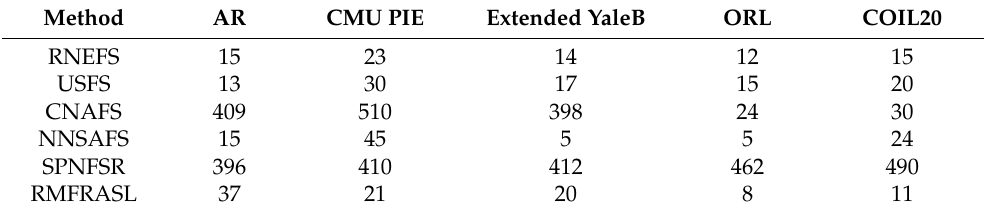
Figure 8. The convergence of the RMFRASL algorithm: ( a ) AR; ( b ) CMU PIE; ( c ) Extended YaleB; ( d ) ORL; ( e ) COIL20. Table 11. The number of iterations of different algorithms on the five databases. Method